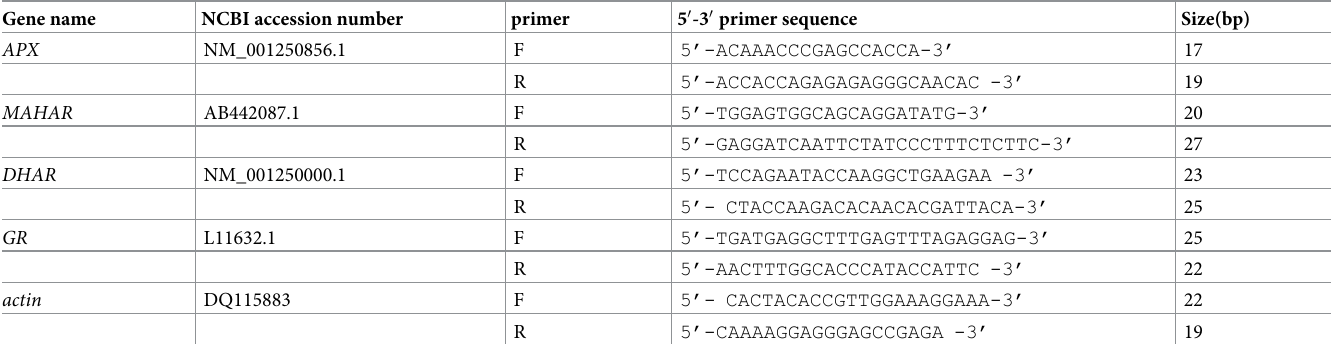
Table 1. Sequences of primers used for RT-PCR